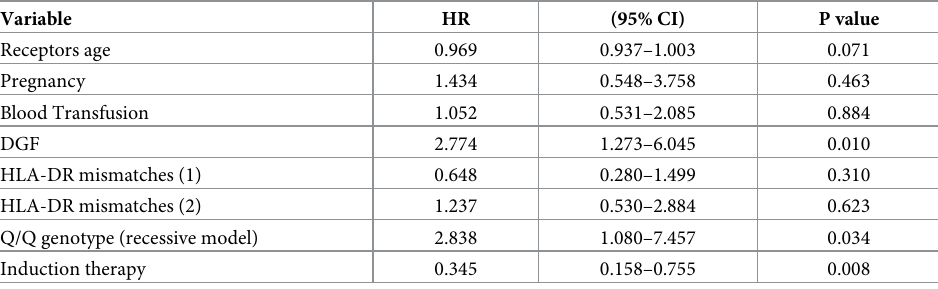
Table 3. Multivariate Cox regression analysis of risk factors for AR.